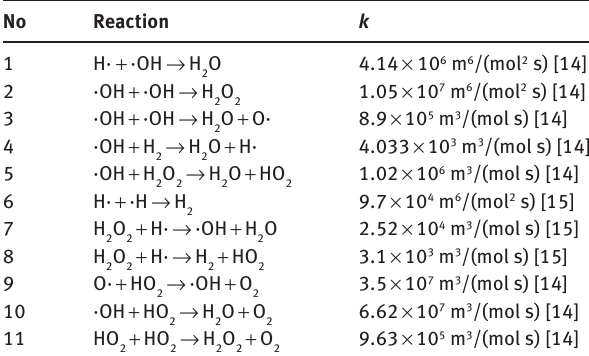
Table 1: Dominant reactions in the gas phase.